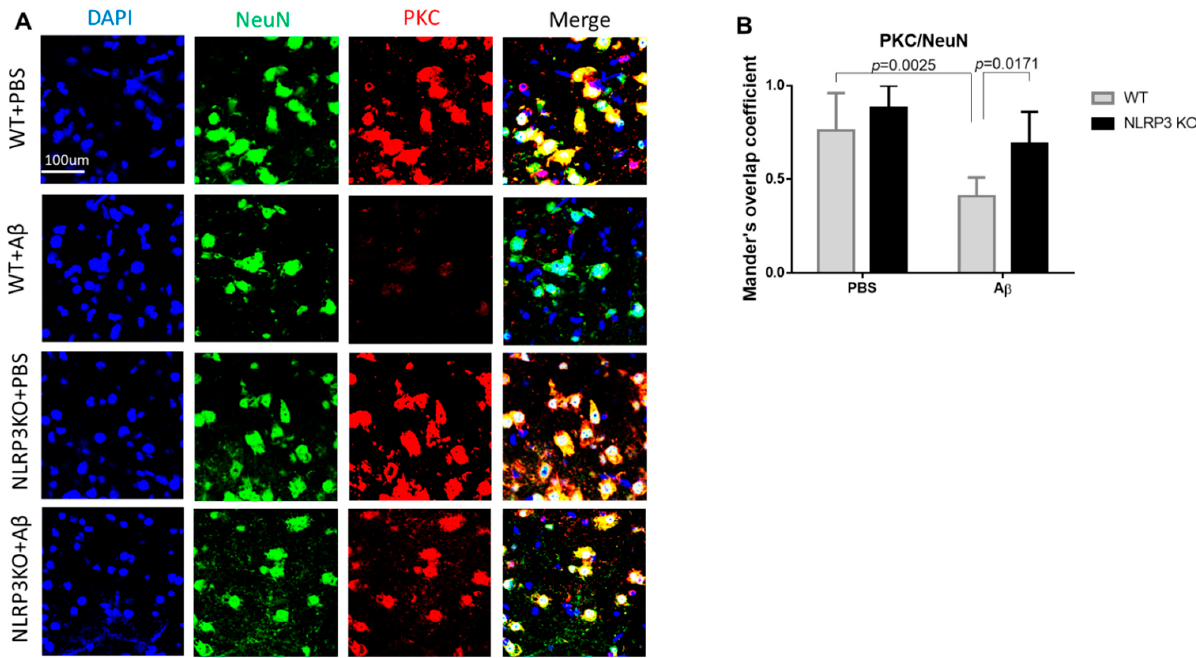
Figure 7. Protein kinase C (PKC) measurements. ( A ) Representative confocal images of PKC-expressing neurons and stained for DAPI (blue), NeuN (green), PKC (red), signal overlay (merge). Scale Bar 100 µ m. ( B ) Mander’s overlap coefficient in PKC+ and NeuN+ double labeling cells. WT—wild type control mice, NLRP3 KO—NLRP3 knockout mice, A β — amyloid beta injection, PBS—phosphate buffered saline injection (sham operation). Data are presented as a mean ± SEM, two-way ANOVA.